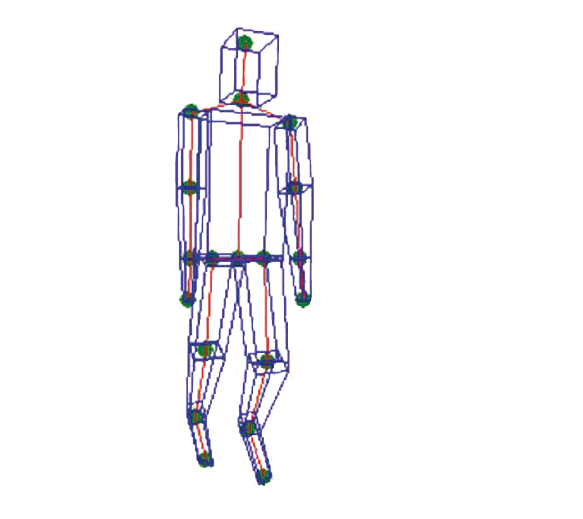
Figure 10: The articulated body model defined by 19 points and 17 segments.